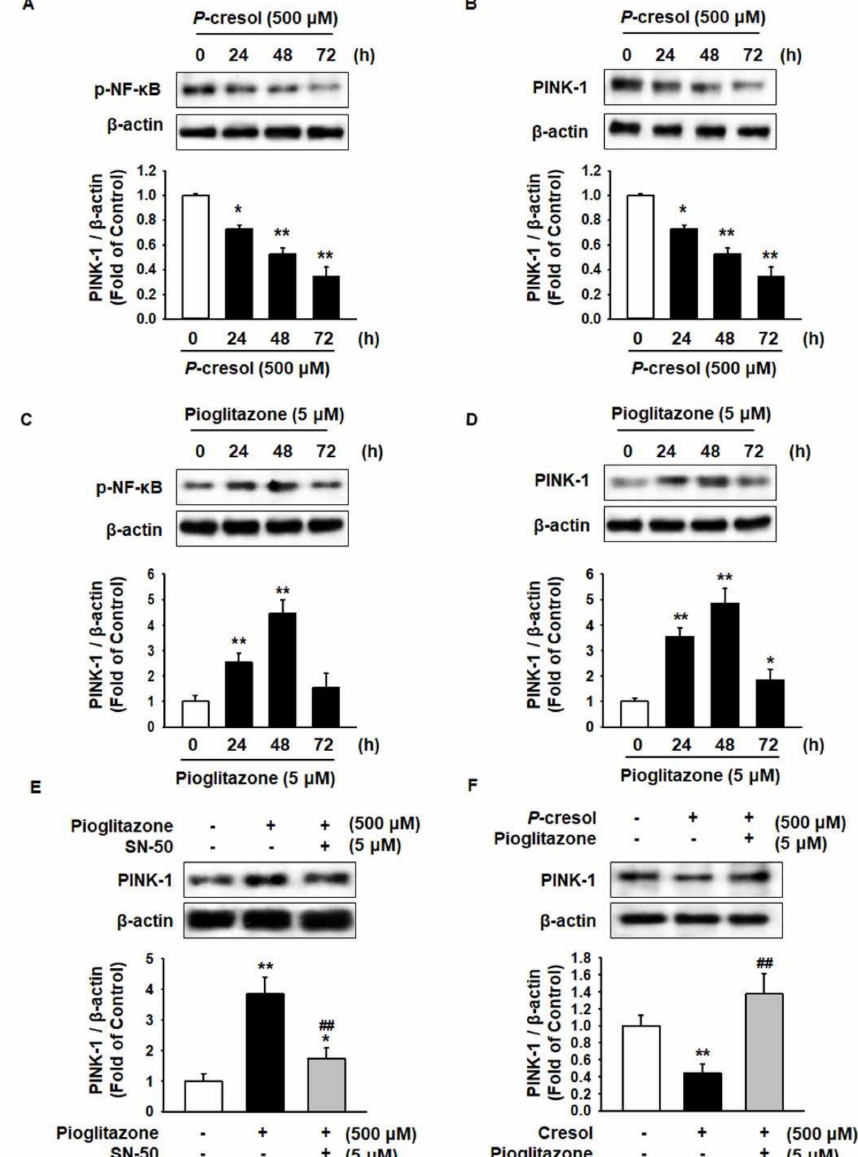
Figure 2. Pioglitazone-treated MSCs increased the expression of PINK-1 through activation of NF- κ B. ( A , B ) Western blot was used to analyze the activation of p-NF- κ B and the expression of PINK-1 in MSCs on exposure to PC (500 µ M) for 0, 24, 48, and 72 h. The expression levels were determined by densitometry relative to β -actin. Values represent the mean ± SEM. * p < 0.05 and ** p < 0.01 vs. untreated MSCs. ( C , D ) Western blot was used to analyze the activation of p-NF- κ B and the expression of PINK-1 in MSCs treated with pioglitazone (5 µ M) for 0, 24, 48, and 72 h. The expression levels were determined by densitometry relative to β -actin. Values represent the mean ± SEM. * p < 0.05 and ** p < 0.01 vs. untreated MSCs. ( E ) Pretreated MSCs with or without NF- κ B SN50 cell permeable inhibitory peptide trifluoroacetate salt (SN-50) for 24 h were analyzed via Western blot for the expression of PINK-1 in the treatment with pioglitazone (5 µ M; 48 h). The expression levels were determined by densitometry relative to β -actin. Values represent the mean ± SEM. * p < 0.05 and ** p < 0.01 vs. untreated MSCs, ## p < 0.01 vs. MSCs treated with pioglitazone. ( F ) MSCs pretreated with or without pioglitazone (5 µ M; 48 h) were analyzed via Western blot for the expression of PINK-1 on exposure to PC (500 µ M; 48 h). The expression levels were determined by densitometry relative to β -actin. Values represent the mean ± SEM. ** p < 0.01 vs. untreated MSCs, ## p < 0.01 vs. MSCs exposed to